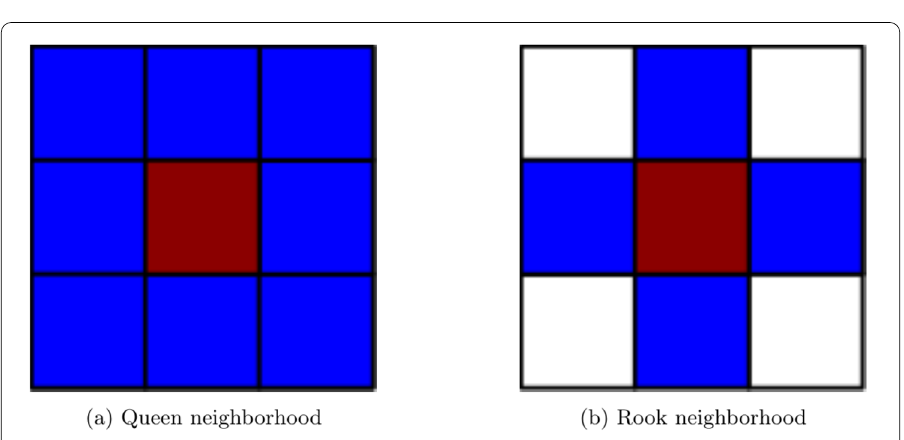
Figure 6 Types of neighborhood for the spatial weight